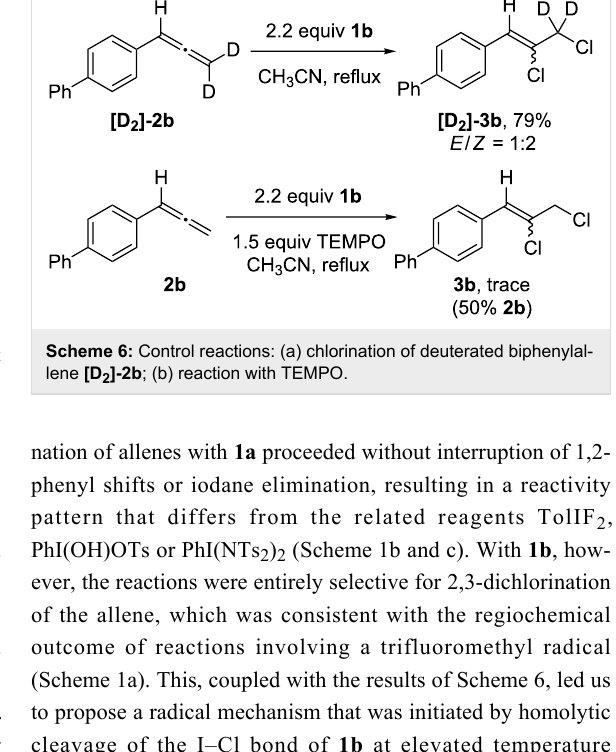
lization of radical intermediates gained upon methoxy substitu- tion [51], which permitted further chlorination of either the methyl or arene groups.